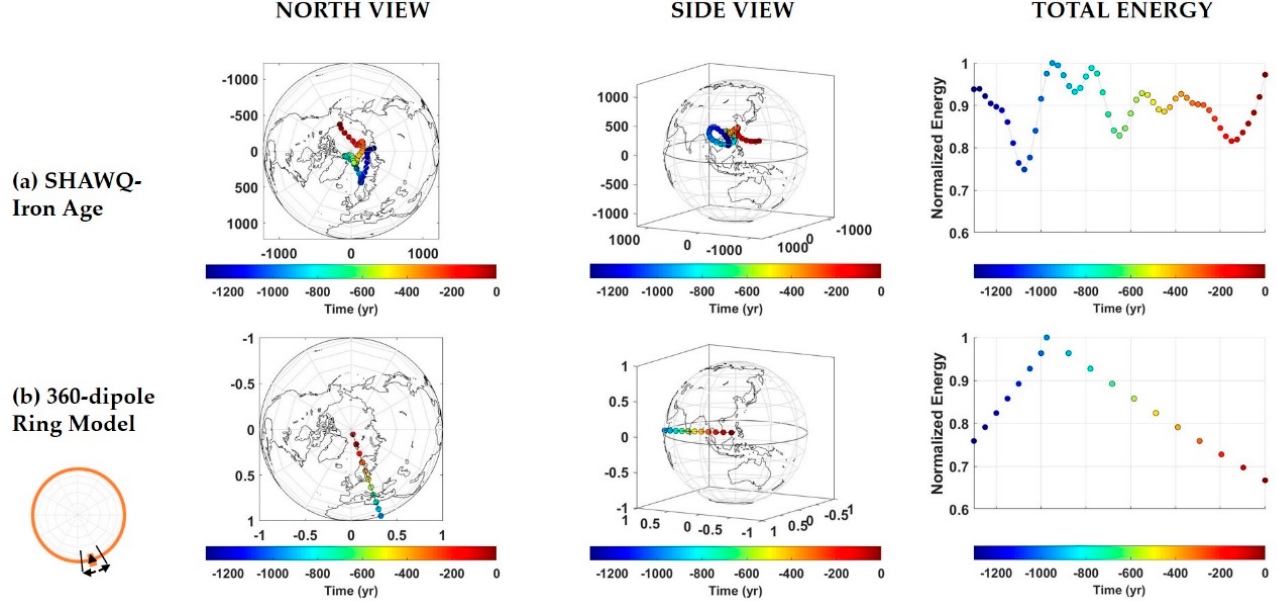
Figure 4. Evolution of the ED and the normalized total energy between 1300 BC and 0 according to ( a ) SHAWQ-Iron Age paleoreconstruction (position in km), and ( b ) the 360-DRM proposed in this paper, increasing by a factor of 5 the magnitude of the dipoles between 10° E and 30° E (see main text). Orange circumference indicates the first dipoles to increase their magnitude (black triangle), the propagation directions (black arrows), and the limits of the region (black lines). Note that in ( b ) the evolution of the ED is dimensionless. Coastlines are plotted only for longitude reference (note they are projected on a sphere of arbitrary radius).